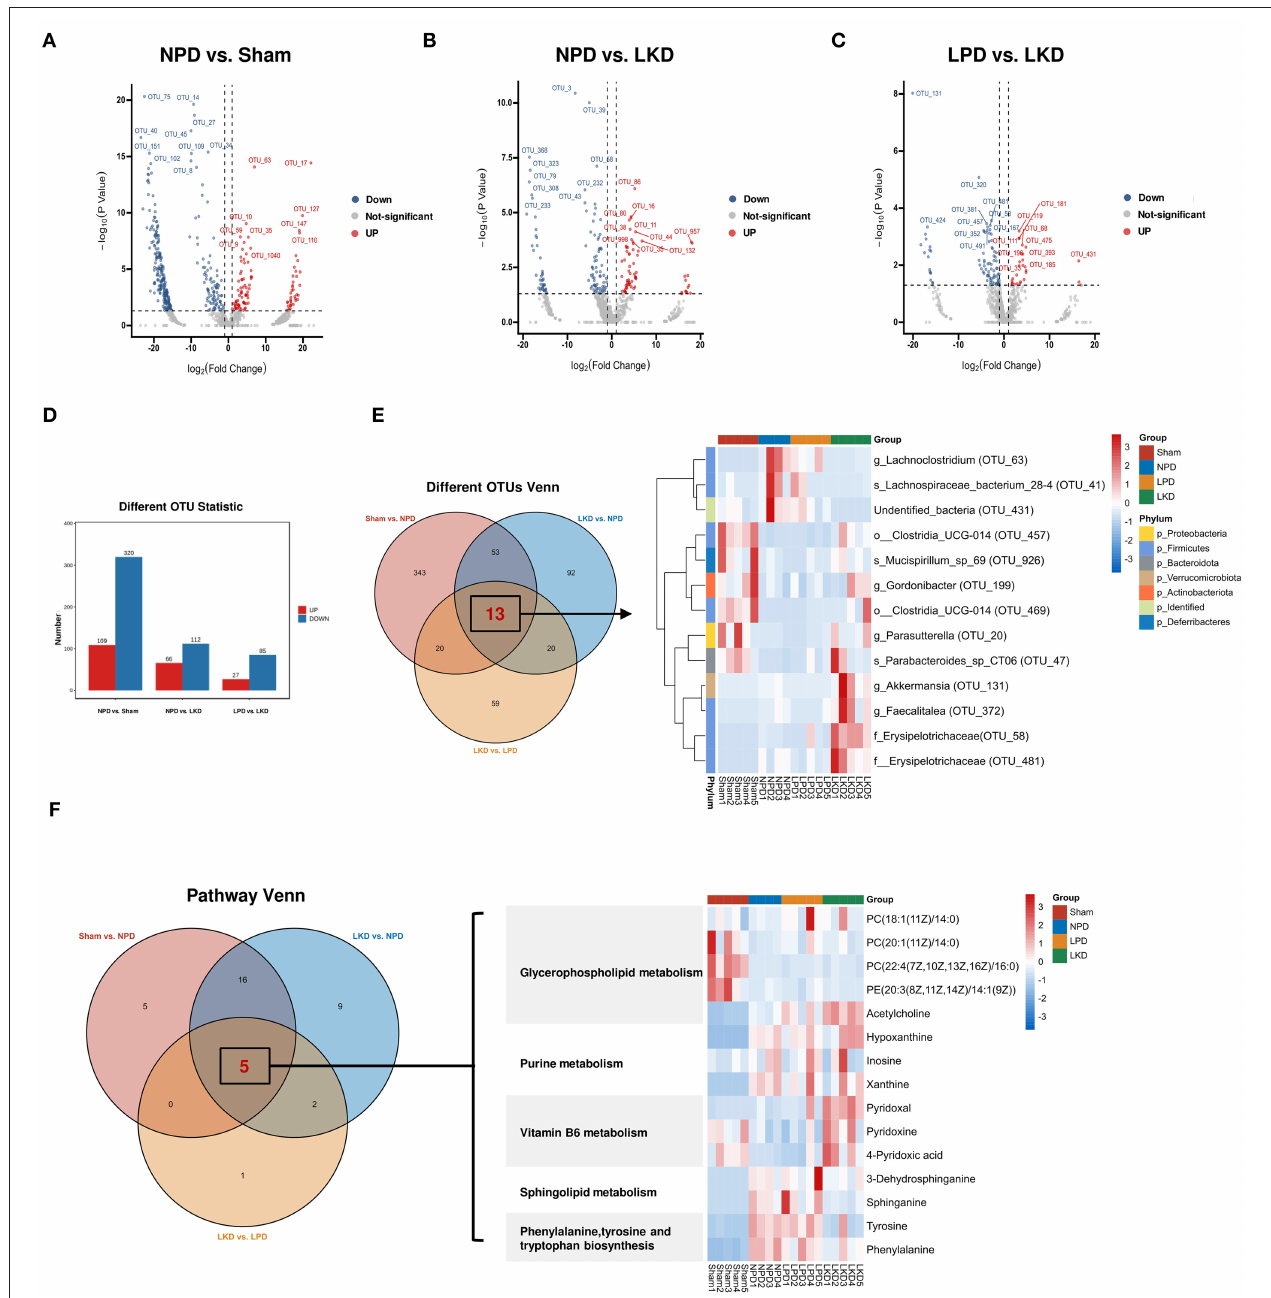
FIGURE 7 | Identification of key DEMs and OTUs associated with LKD. (A–C) Volcano plots showing differential OTUs by DEseq2. (A) NPD vs. sham. (B) NPD vs. LKD. (C) LPD vs. LKD. (D) Histogram showing different numbers of OTUs among three comparisons. (E) Venn plot showing the overlapped differential OTUs among three comparisons; heatmap showing the abundance of overlapped differential OTUs. (F) Venn plot showing the overlapped differential KEGG metabolic pathways among three comparisons; heatmap showing the DEMs (NPD vs. LKD) involved in these pathways.